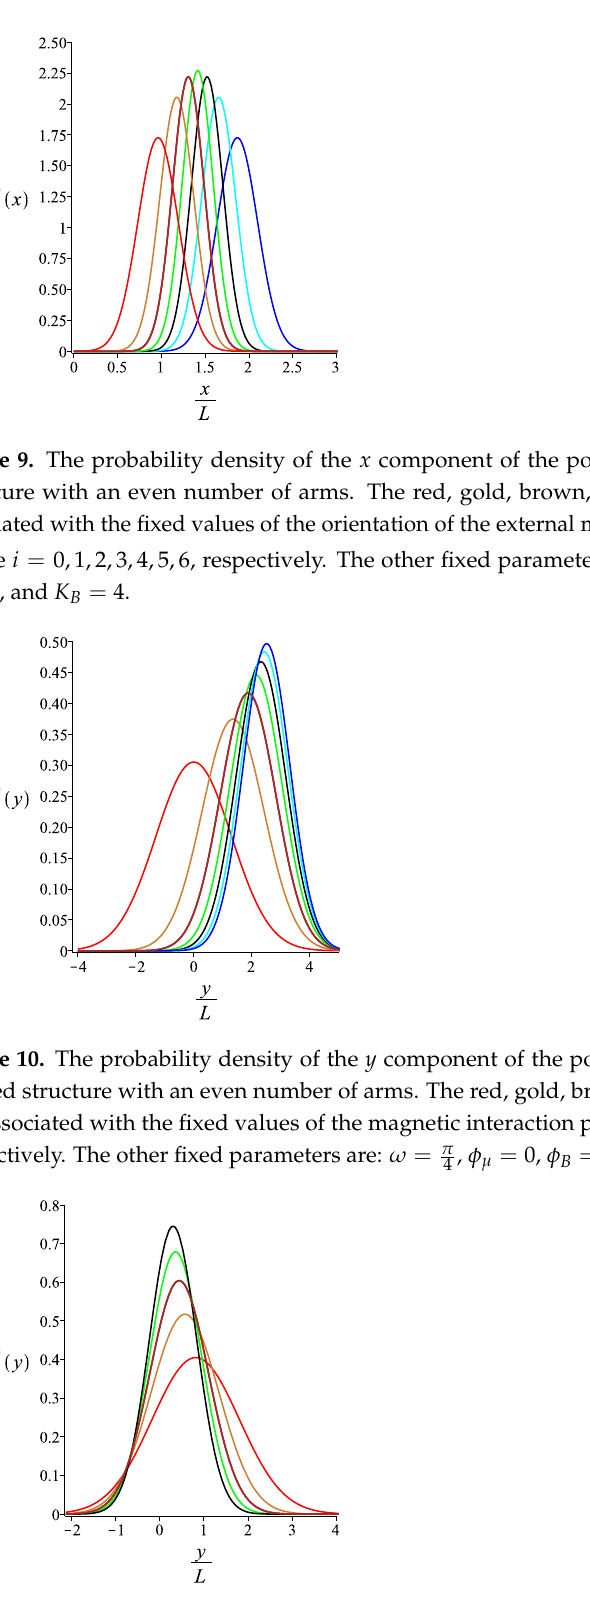
Figure 11. The probability density of the y component of the position of the free endpoint of the grafted structure with an even number of arms. The red, gold, brown, green, and black are associated = 12.5 i , where i = 1,2,3,4,5, respectively. The with the fixed values of the stiffness parameter, l p L other fixed parameters are: ω = π , φ µ = 0, φ B = 0 n = 2, and K B = 4